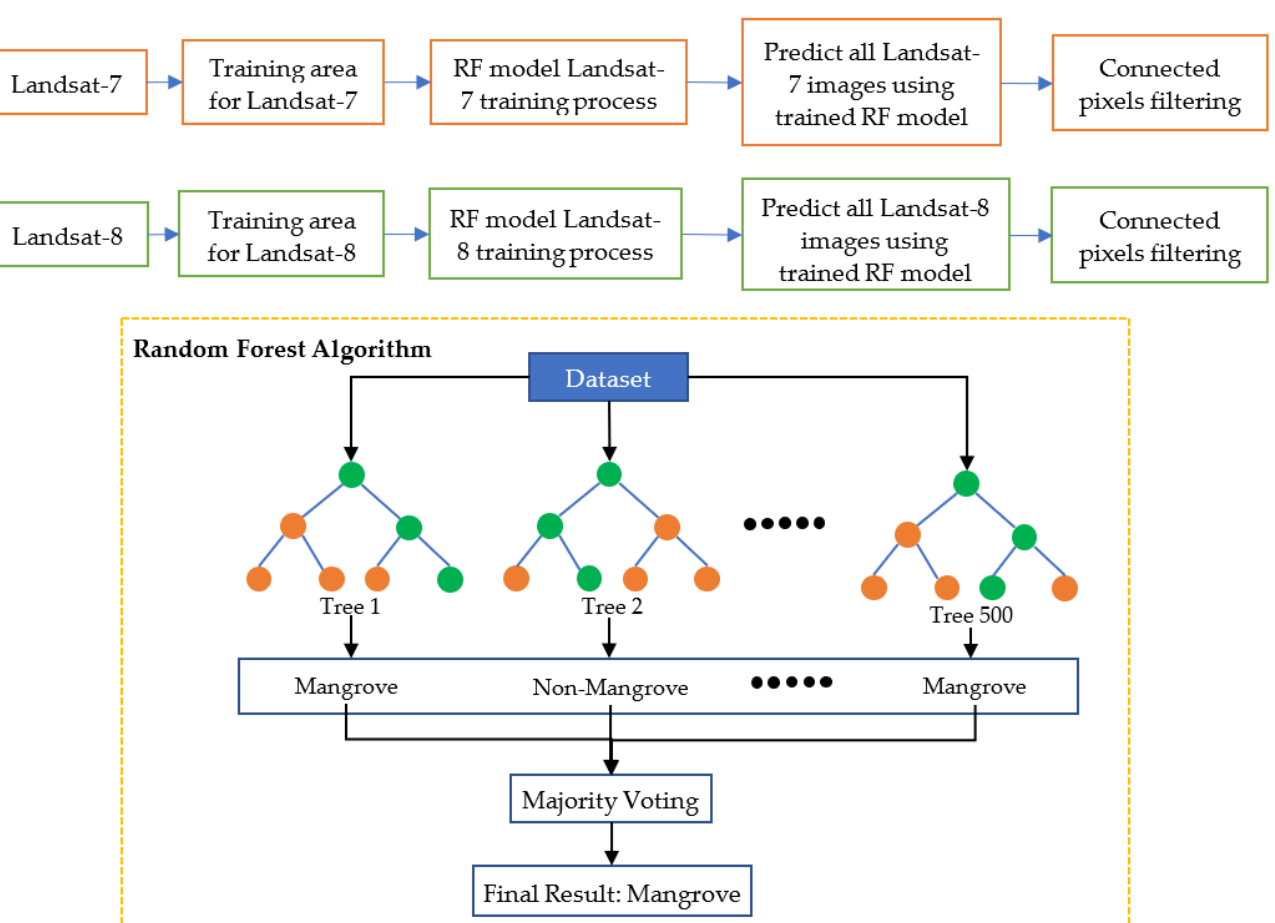
Figure 3. Random forest algorithm for this study. Table 4. Total training pixels for Landsat-7 and Landsat-8.